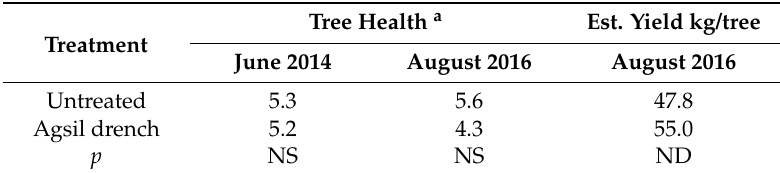
Table 6. Tree health data for 2014 and 2016 and estimated yield 2016 from Agsil amendment trial—Site 4, Comboyne.